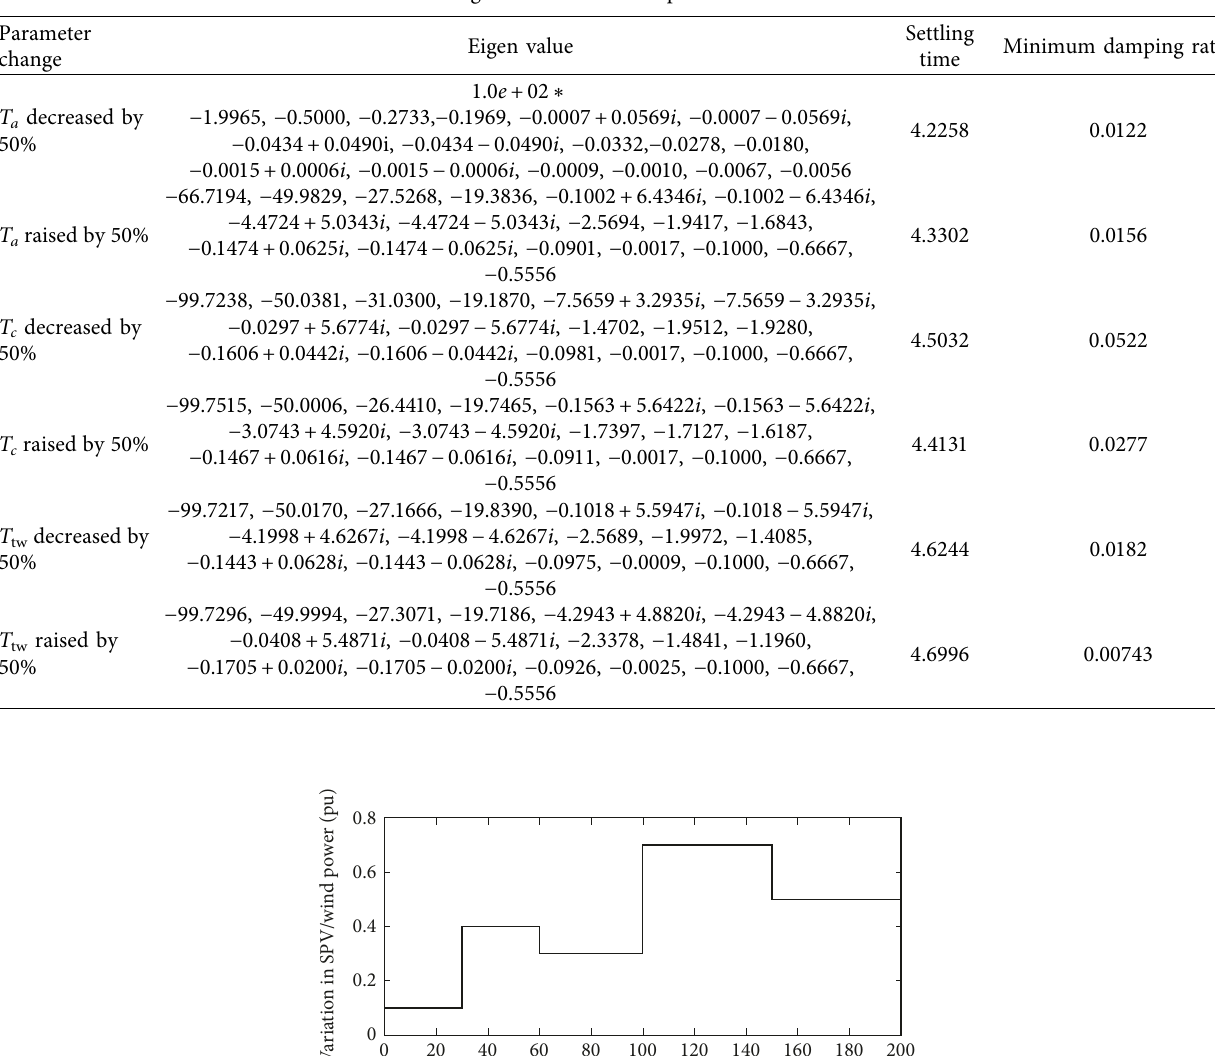
Table 8: Eigen distributions for parametric variations.